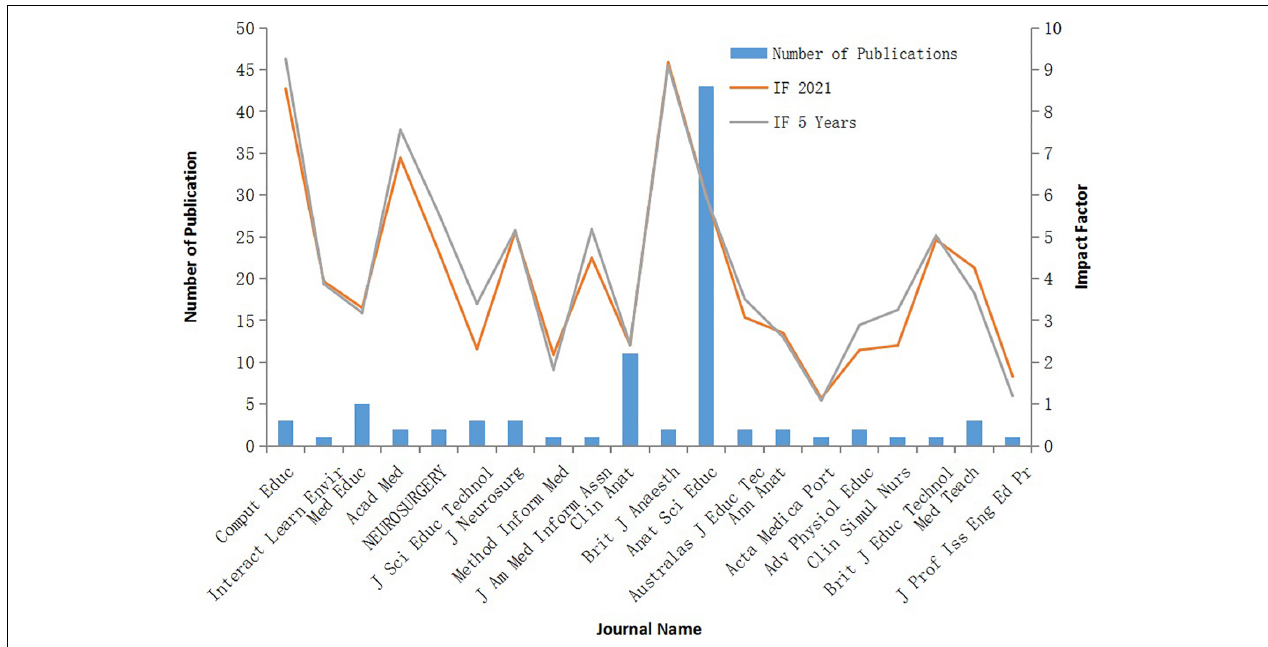
FIGURE 10 | The impact factor and contribution of